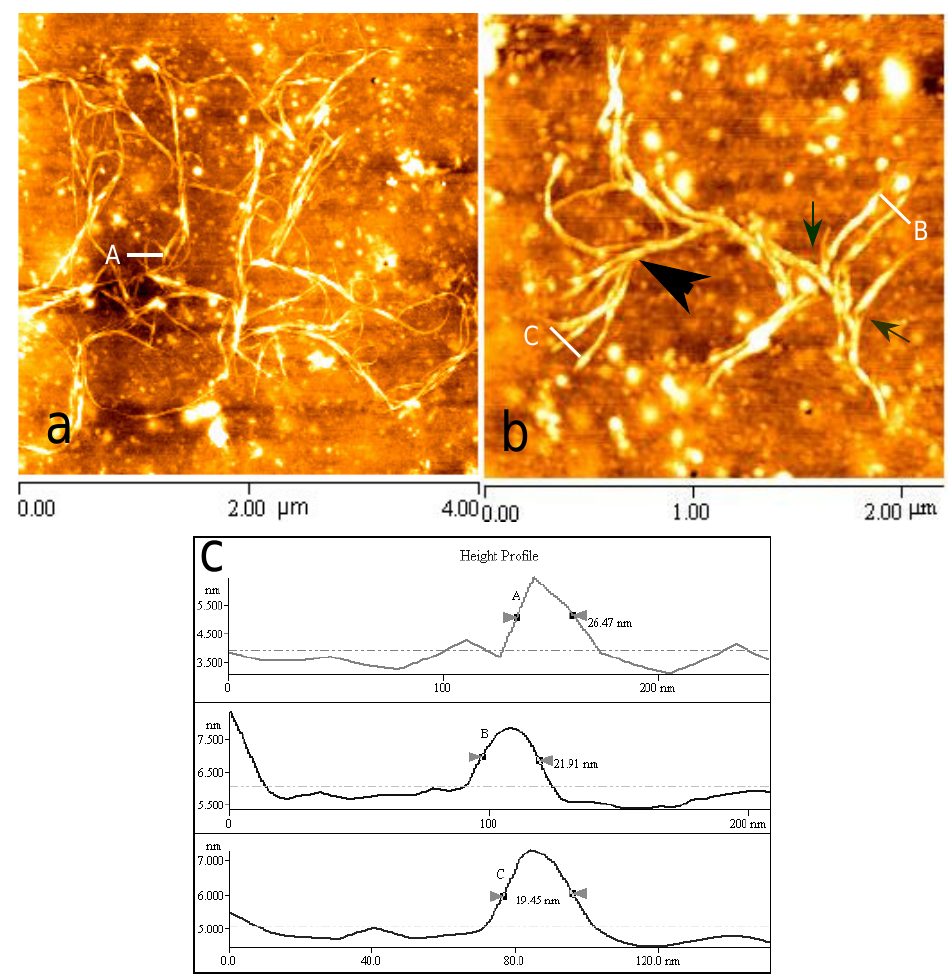
Figure 2. Morphological image of chitosan molecule chain (a, b). The molecular chains of chitosan accumulate to present dendritic structures (blue arrows). (c) The height profiles A, B and C were